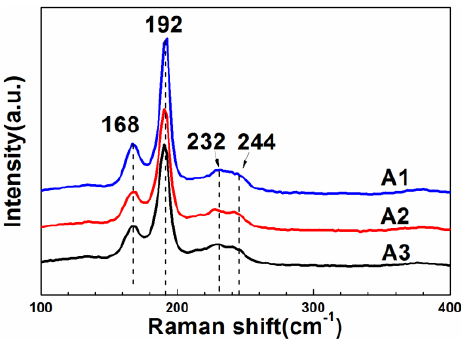
Figure 3. The Raman spectra of the CZTSe films that were prepared by the selenization of the precursor with samples A1, A2, and